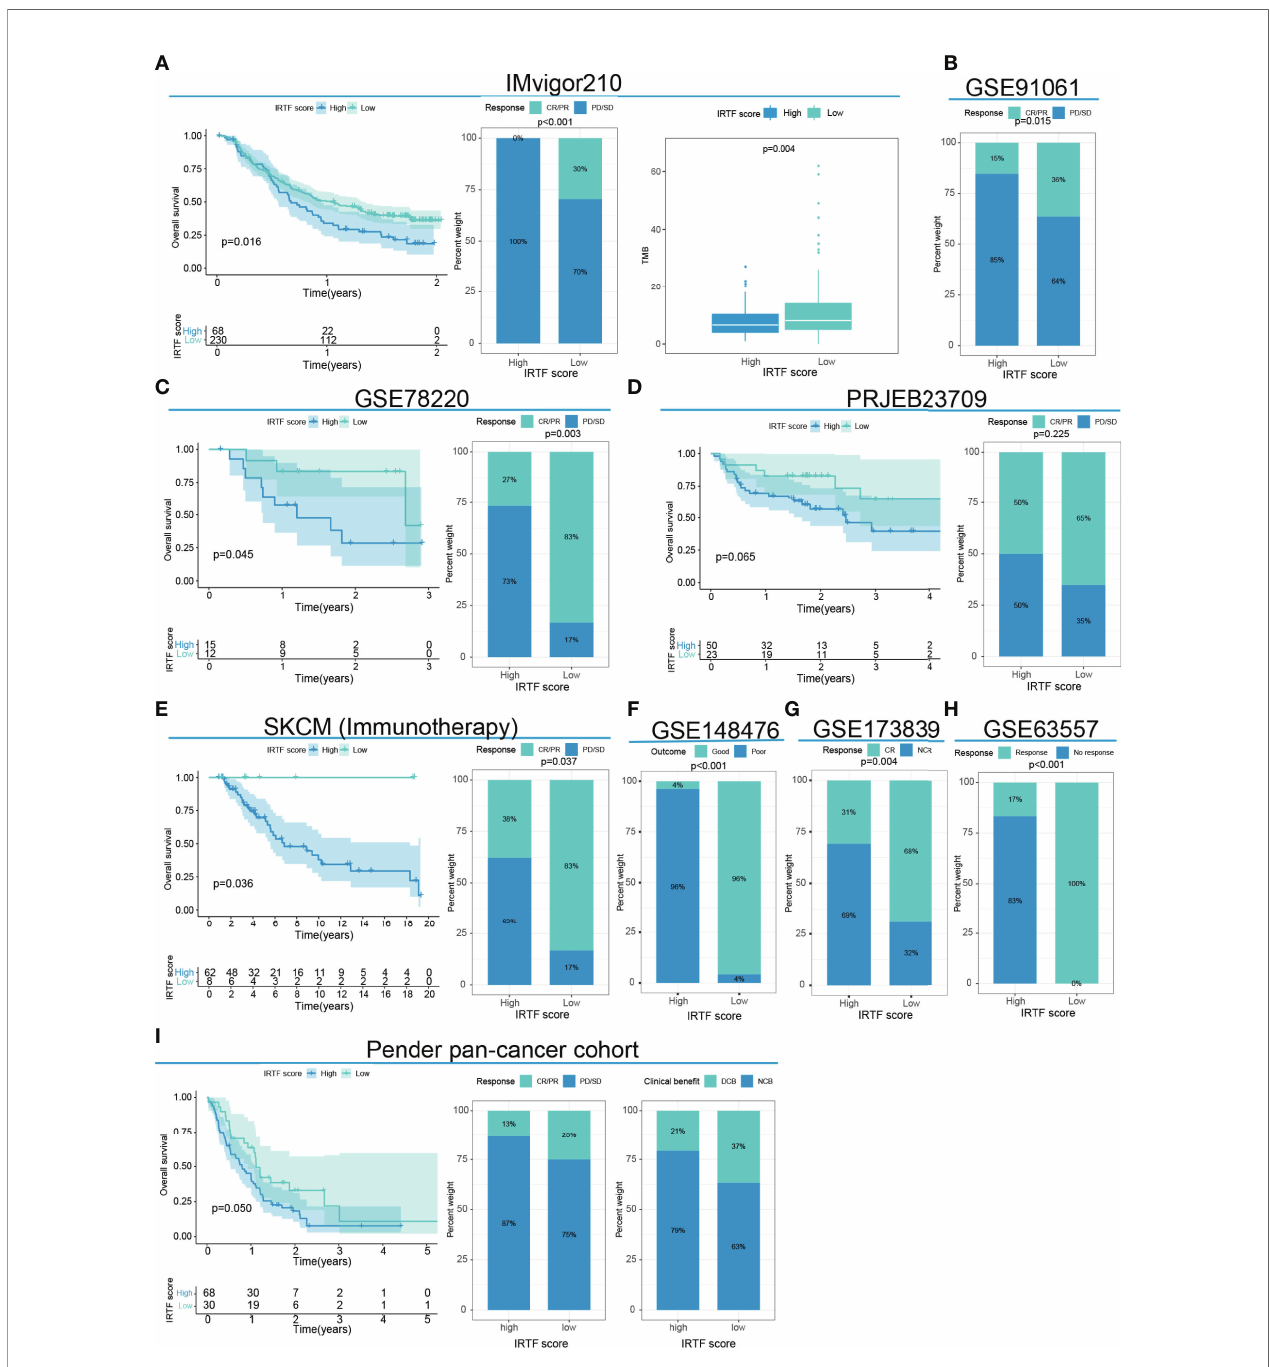
FIGURE 5 | IRTF score system in the role of immunotherapy of multi-cancer. (A) Survival analysis, the proportion of patients showing a response, and TMB level in the low or high IRTF score groups of the IMvigor210 cohort with the anti-PDL1 antibody. (B) The proportion of patients showing a response to anti-PD1 antibody in the low or high IRTF score groups of the GSE91061 cohort. (C) Survival analysis and the proportion of patients showing a response in the low or high IRTF score groups of the GSE78220 cohort with anti-PD1 antibody. (D) Survival analysis and proportion of patients showing a response in the low or high IRTF score groups of the PRJEB23709 cohort with anti-PD1 antibody/anti-PD1 antibody+anti-CTLA4 antibody. (E) Survival analysis and proportion of patients showing a response in the low or high IRTF score groups of the SKCM (Immunotherapy) cohort with various types of immunotherapies. (F) The proportion of patient showing a response in the low or high IRTF score groups of the GSE148476 cohort with various types of immunotherapies. (G) The proportion of patient showing a response in the low or high IRTF score groups of the GSE173839 cohort with neoadjuvant immunotherapy (H) The proportion of mice showing a response to anti-CTLA4 antibody in the low or high IRTF score groups of the GSE63557 cohort. (I) Survival analysis and the proportion of patients showing a response and clinical bene fi t in the low or high IRTF score groups of the Pender pan -cancer immunotherapy cohort with various types of